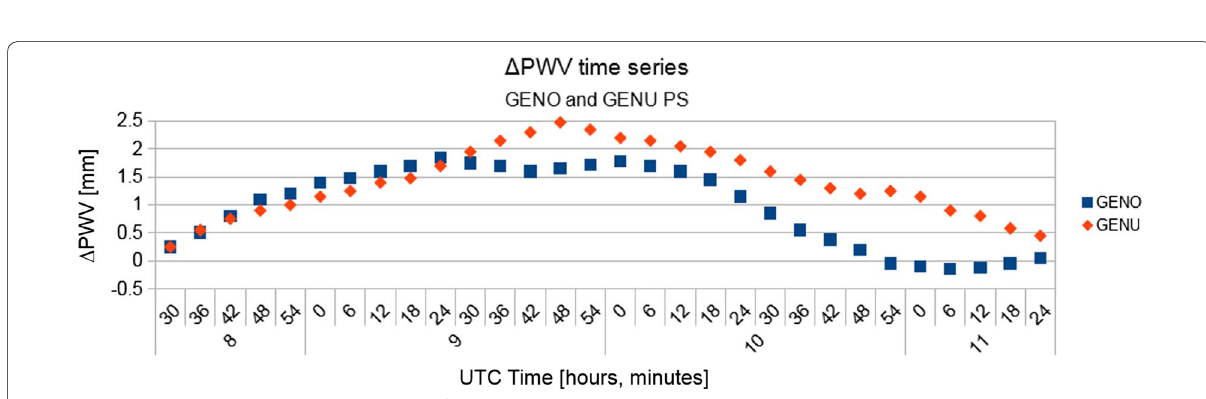
Fig. 17 ∆PWV time series over Genoa PSs on November 4,